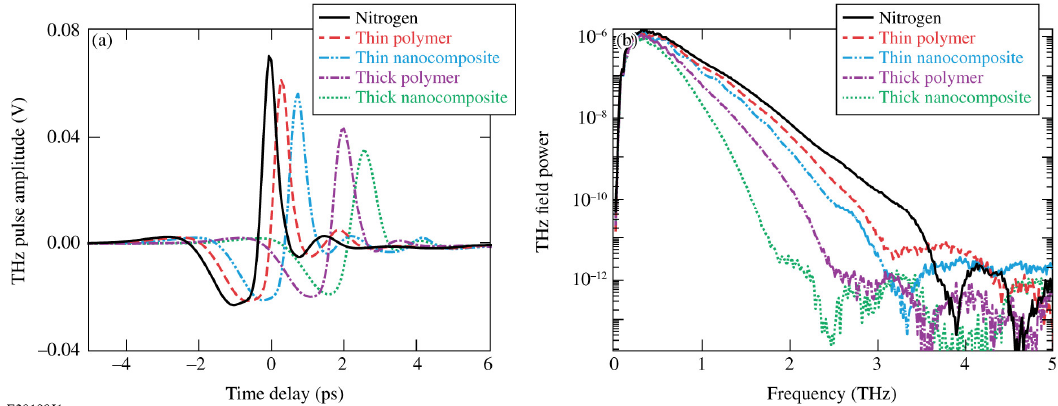
Figure 5. ( a ) Time-resolved transient signals for the tested thin and thick polymers and 1-wt% graphene nanocomposite samples and the empty spectrometer (nitrogen). ( b ) The corresponding power spectra showing absorption of the samples. Note: The thin samples consist of the PET-DLA 4060 copolymer, while the thick ones consist of PET-DLA 6040.